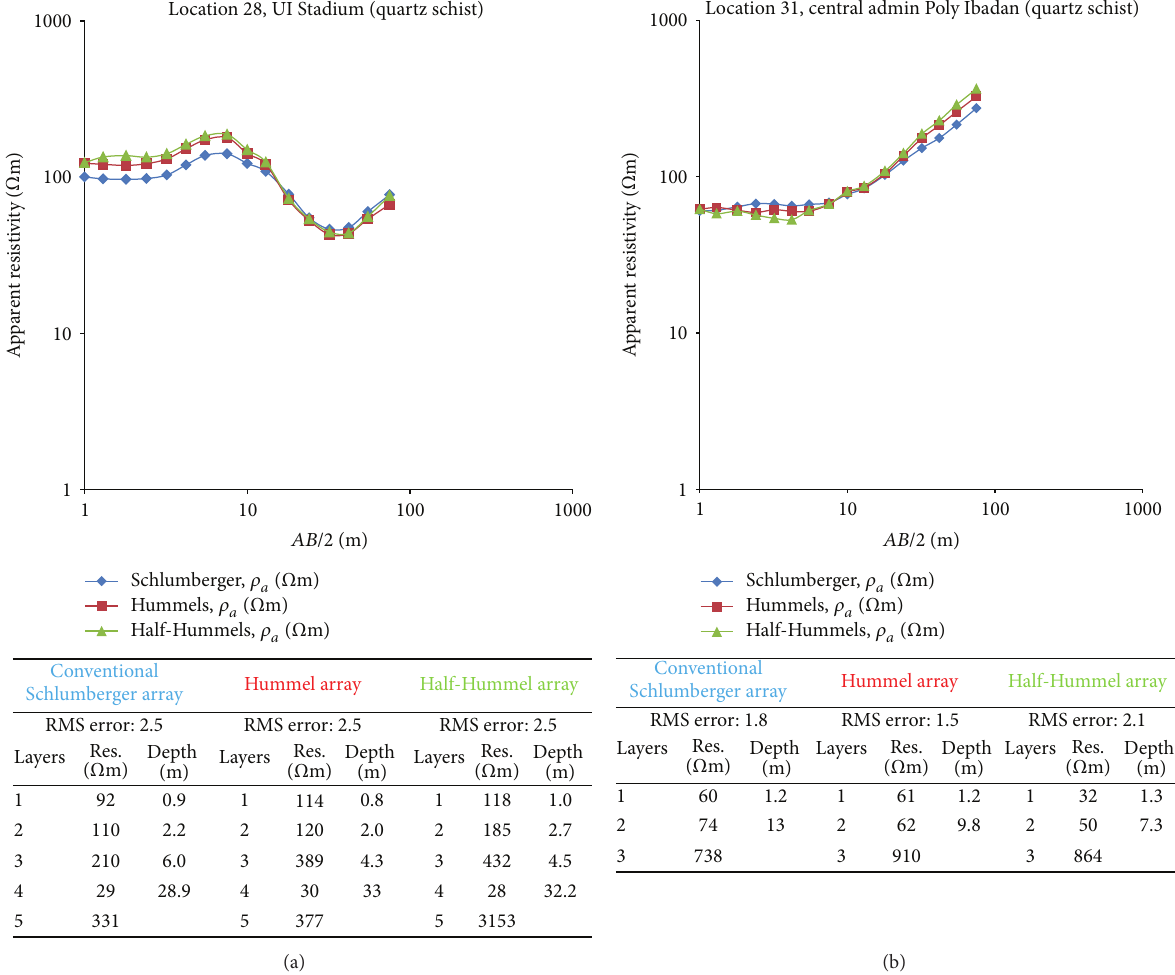
locations with augen gneiss lithology have maximum number of four layers. The range of weathered layer resistivity is between 16 and 561 Ω m, with overburden thickness between 5.0 and 39.9 m; the basement resistivity ranges between 46 and 13333 Ω m for the different array methods